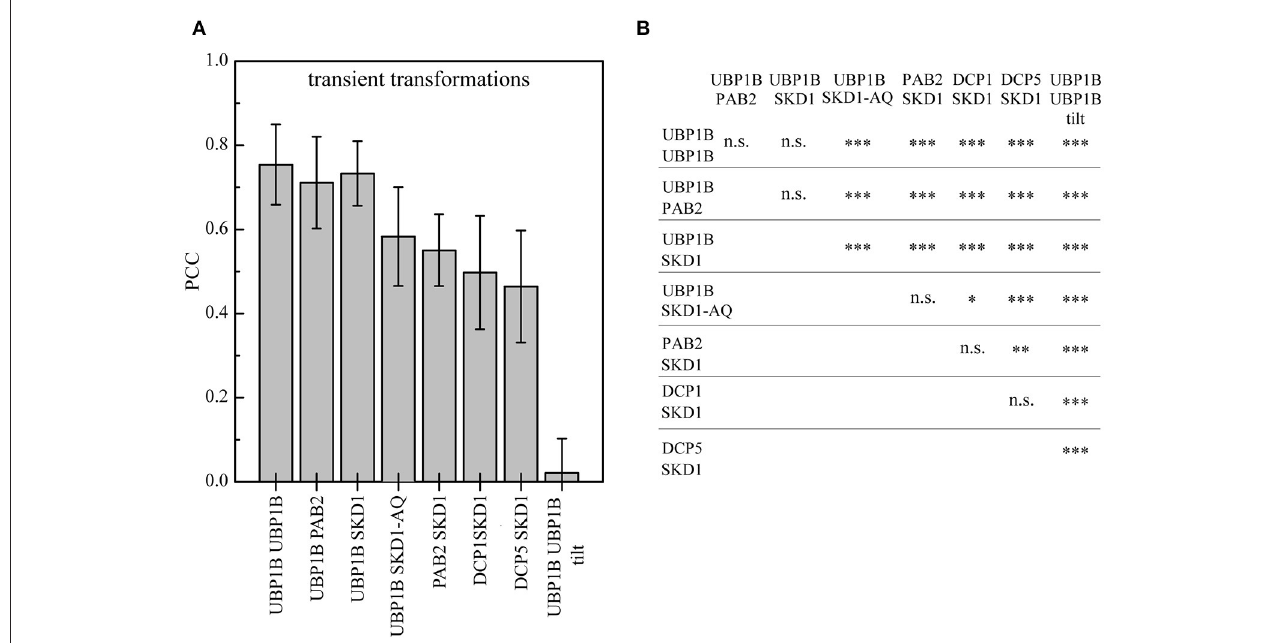
FIGURE 3 | Quantification of SKD1 co-localization with different mRNP granule markers after heat stress. Leaf epidermal cells were transiently double transformed with constructs overexpressing ( 35S promoter) SKD1 in C-terminal fusion with YFP or mCHERRY and an mRNP granule marker (YFP-UBP1B, mCHERRY-PAB2, DCP1-CFP, or DCP5-YFP). The transformed leaves were subjected to heat stress and imaged by CLSM. Maximum projections of stacks were generated. For each combination, three ROIs in 10 cells were analyzed for signal overlap using the Pearson’s coefficient (PCC). As positive controls, cells were co-transformed with YFP-UBP1b and mCHERRY-UBP1b or mCHERRY-PAB2. As a negative control, one channel of the YFP/mCHERRY-UBP1b pictures was rotated by 180 ◦ before analysis (“tilt”). (A) Mean overlaps of the different combinations are depicted in a histogram and error bars indicate standard deviation. (B) Statistical significance analysis of co-localizations. Significance levels are indicated as following: n.s., not significant, * p ≤ 0.05, ** p ≤ 0.01, *** p ≤ 0.001.